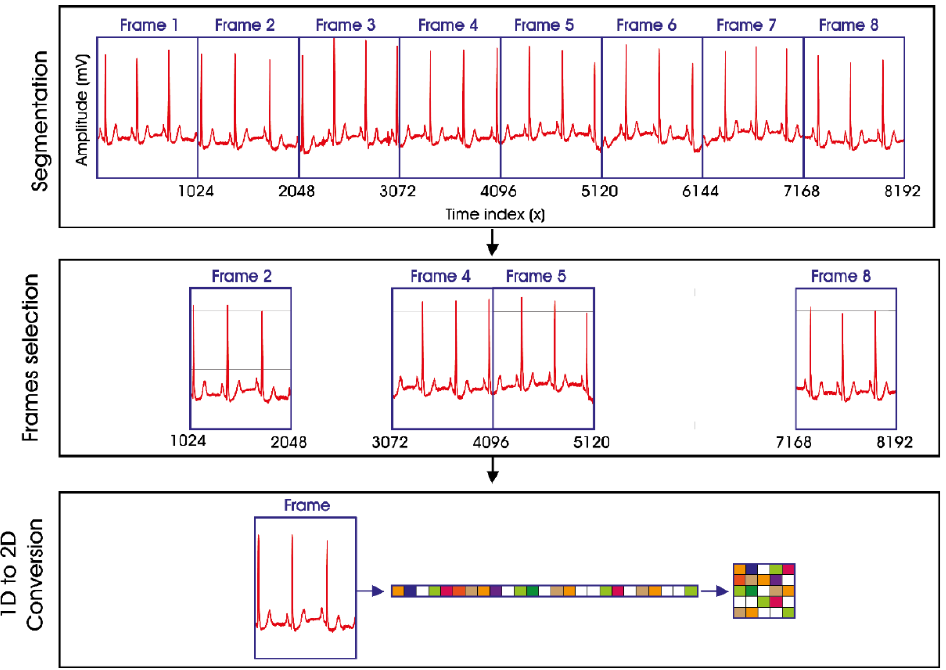
Figure 5. Pre-processing phase of the bio-signal to be copyrighted.